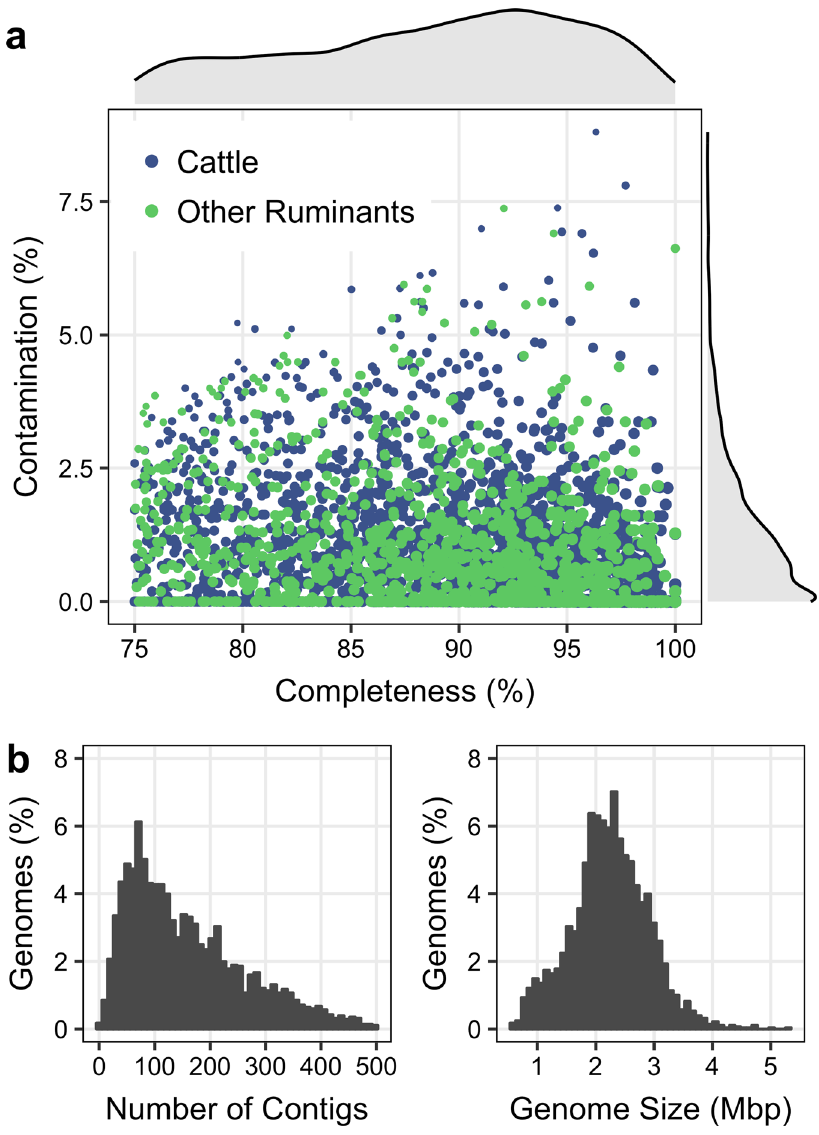
Fig. 1 Genomic properties of 2,809 rumen MAGs. a CheckM completeness and contamination estimates for the 2,809 population genomes recovered from rumen metagenomes. The size of the point on the scatter plot corresponds to the dRep genome quality score, where Quality = Completeness − (5 ⋅ Contamination) + (Contamination ⋅ (Strain Heterogeneity/100)) + 0.5 ⋅ (log(N50). The reported MAGs meet the following minimum criteria: genome quality score ≥ 60, ≥ 75% complete, ≤ 10% contamination, N50 ≥ 5 kbp, and ≥ 500 contigs. b The frequency distribution of the number of contigs and genome sizes of reconstructed